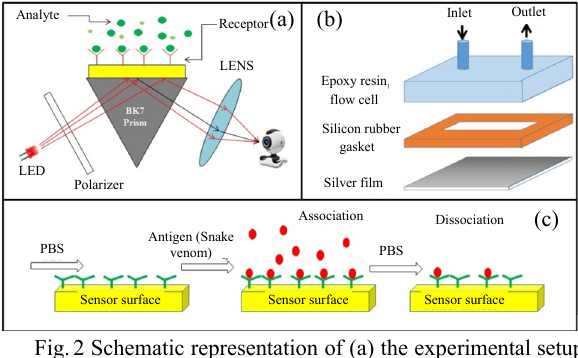
Fig. 2 Schematic representation of (a) the experimental setup, (b) flow cell, and (c) sensor measurement procedure.